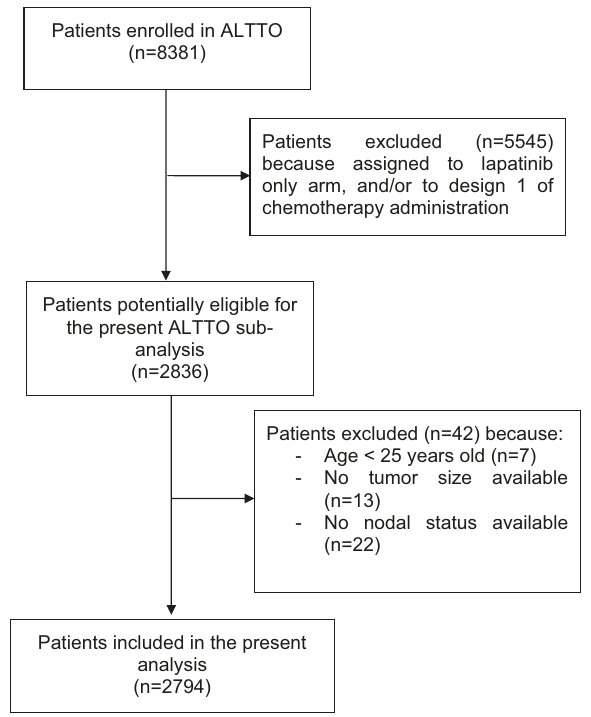
Fig. 1 STROBE fl ow-chart. This fi gure illustrates the patient selection